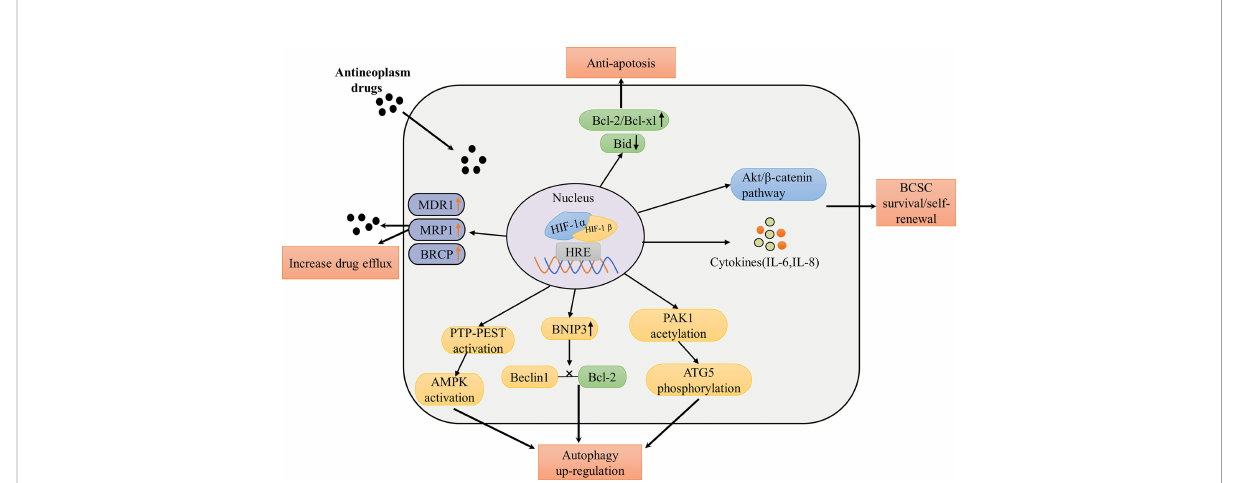
FIGURE 4 Summary of mechanisms and pathways of HIF-1 a mediated drug therapy failure in breast cancer. The pathways of resistance to conventional treatment of HIF-1 a include: increasing expression of drug ef fl ux protein leads to drug e fl lux, increasing expression of anti-apoptotic protein and decreasing expression of pro-apoptotic protein enhance anti-apoptotic effect; phosphorylated Akt/ b -catenin pathway and increased cytokine levels promote survival and self-renewal of breast cancer stem cells; promoting the expression of PTP-PEST to activate AMPK, increasing the expression of BNIP3 to interfere the interaction between Beclin1 and Bcl-2 and inducing the acetylation of PAK1to phosphorylate ATG5 promote the upregulation of autophagy. MDR1, multidrug resistance protein 1; MRP1, MDR-related protein 1; BCRP, breast cancer resistance protein; IL, interleukin; ATG5, autophagy-related 5; AMPK, AMP-activated protein kinase; Beclin1, a protein for regulating the formation of autophagosome membranes; Bcl-2 and Bcl-xl, antiapoptotic proteins; Bid, a pro-apoptotic protein; PAK1, p21 activated kinase 1; PTP-PEST, the protein tyrosine phosphatase